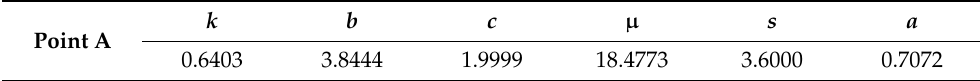
Table 2 summarizes the determined distribution parameters (3). Table 2. Parameters of the determined distributions.